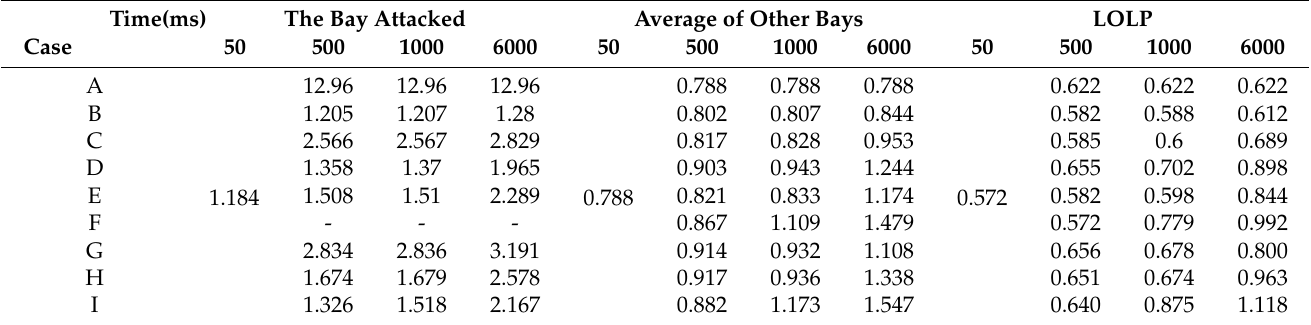
Table 6. Record table of critical time probability of multi-type attacks (unit: